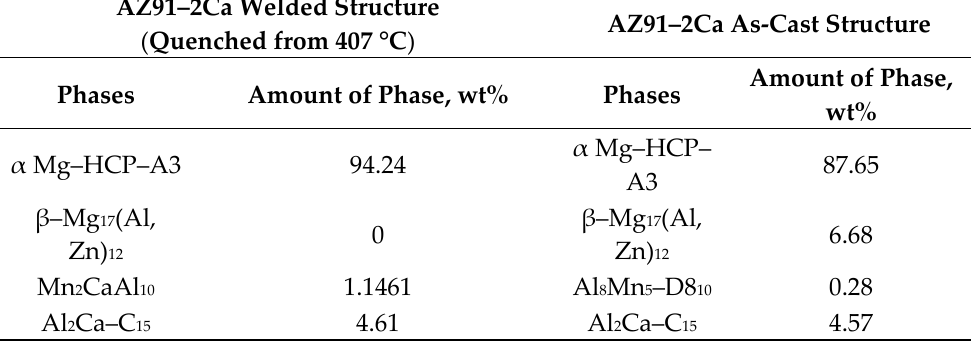
Table 6. Phase predictions for AZ91–2Ca at the maximum welding temperature and in the as-cast